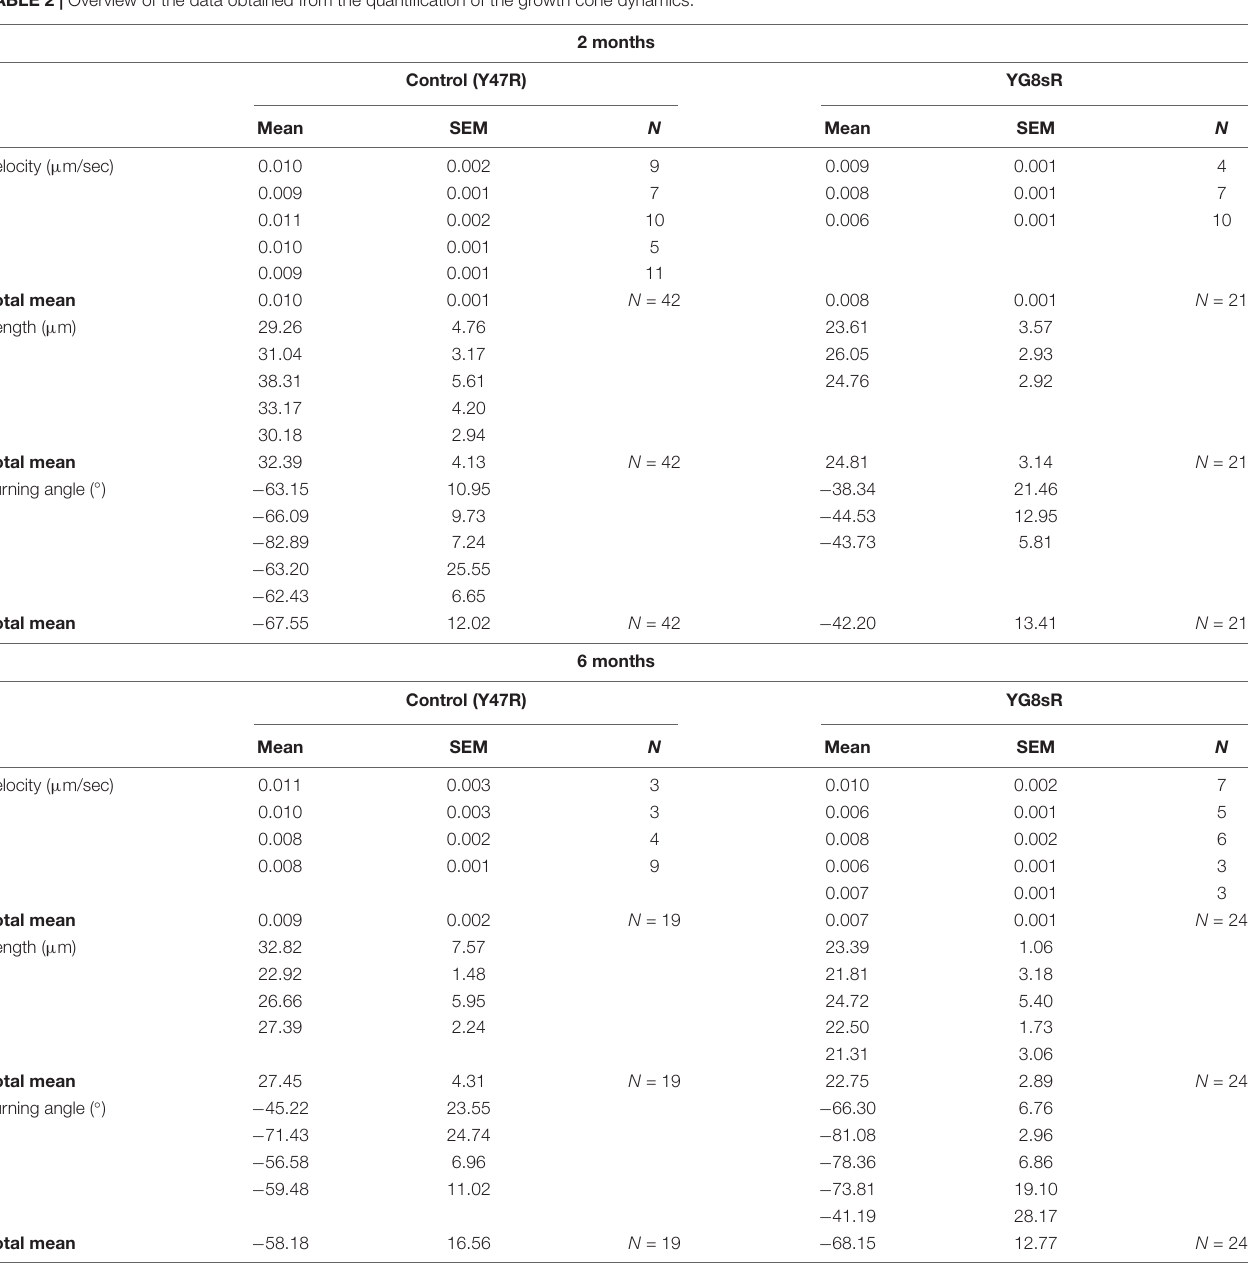
TABLE 2 | Overview of the data obtained from the quantification of the growth cone dynamics.